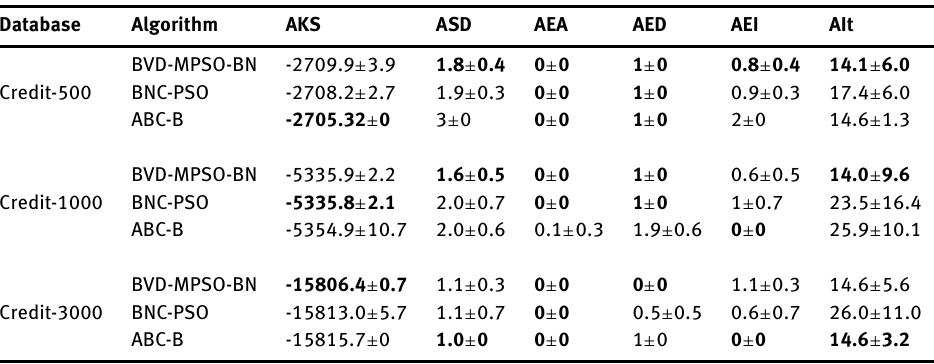
Table 6. The experimental results of three algorithms on Credit